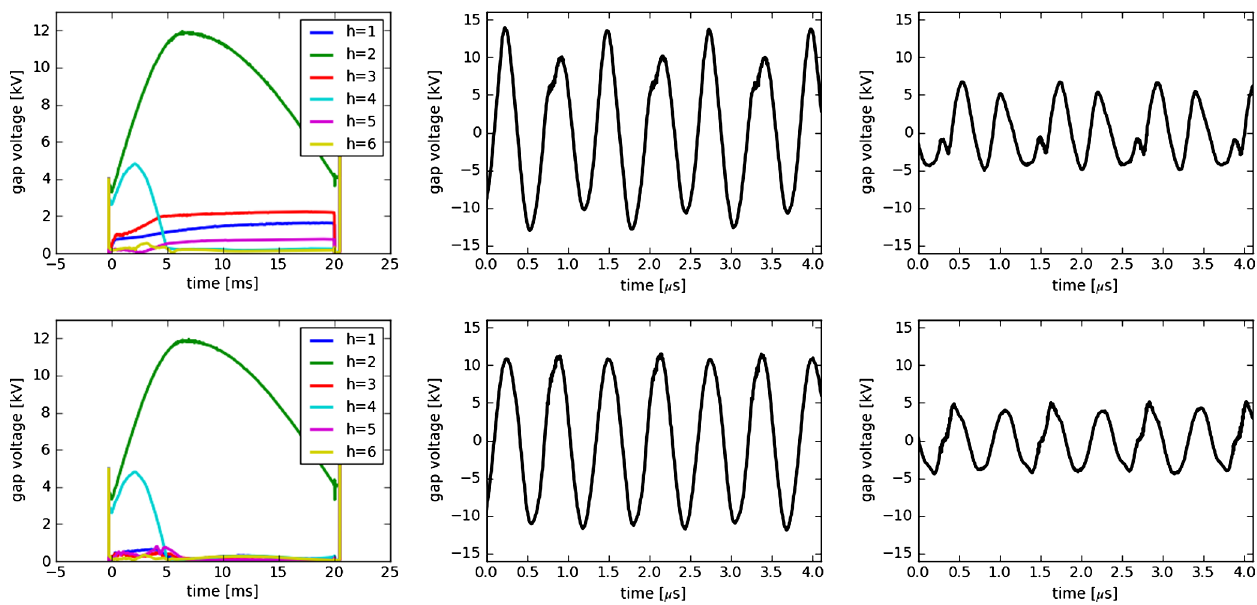
FIG. 2. Left: the harmonic components of the gap voltage of cavity #5 and the gap voltage waveforms at (middle) middle of acceleration (10 ms) and (right) just before extraction (19.9 ms). Upper plots are without feedforward and the lower plots are with feedforward after commissioning.